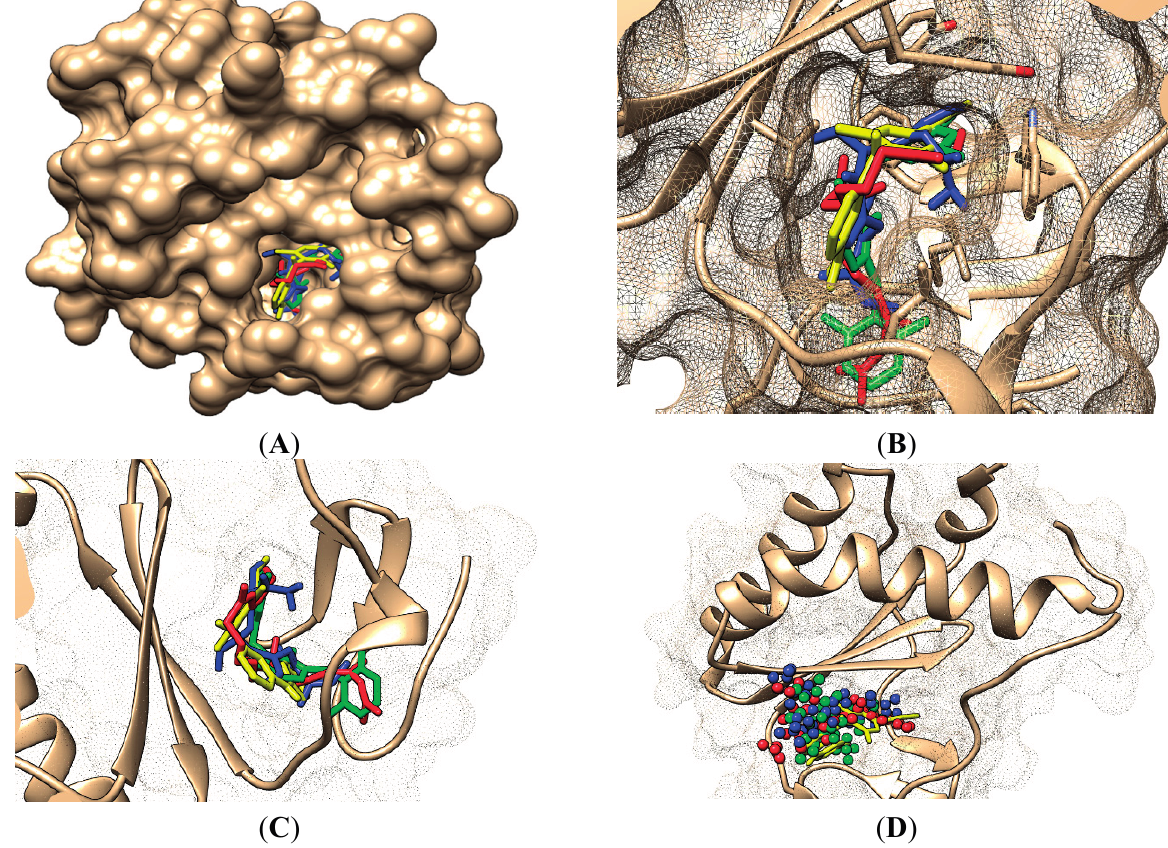
Figure 4. ( A ) The structure of HIV-1RT with rilpivirine drug bounded in a known place/ situs to protein as our molecules; ( B ) more details on the docking of rilpivirine drug and the molecule no. 25 of Table 1; ( C ) still a different variant of 1-Click Docking results with molecule 25, yet with dashed surface and without adjacent amino acids; and ( D ) The PatchDock result of molecule no. 25, with the same color legend: the Genuine, BraS, and LoSMoC as green, red, and blue sticks,